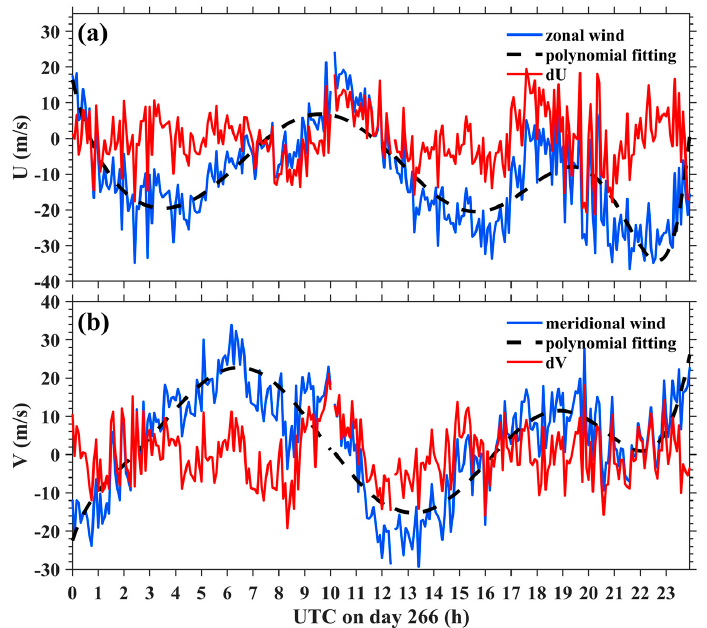
Figure 5. ( a ) Total zonal wind variations (blue line), polynomial fitted wind (black dotted line), and the wind perturbation (red line) on day 266 in 2013. Similarly, ( b ) indicates the result for meridional wind.